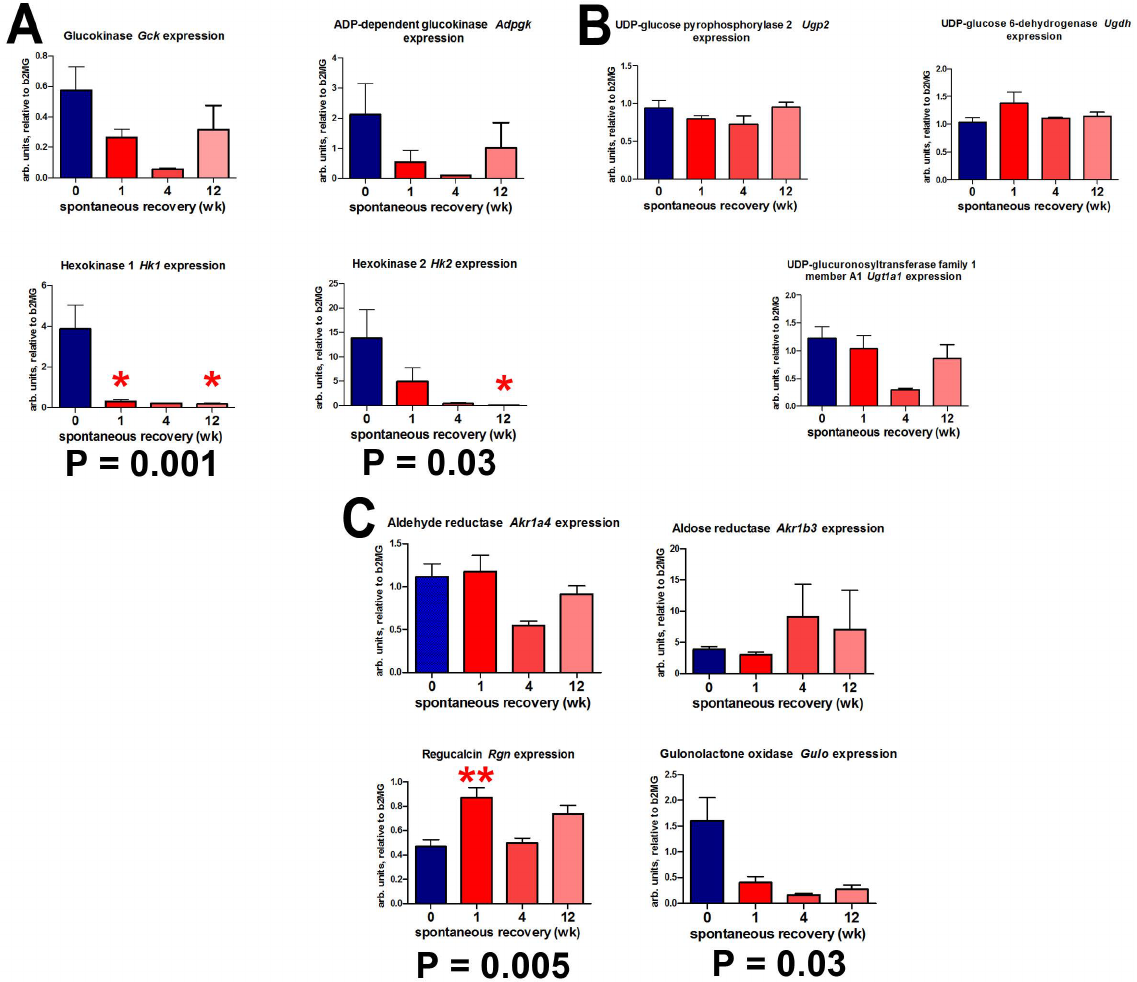
Figure 9. Expression of mouse genes involved in ascorbic acid synthesis from glucose and galactose during spontaneous recovery (for 1–12 week) from HF-CDAA diet-induced liver fibrosis. ( A ). The phosphorylation of hexoses pathway. ( B ). The synthesis of glucuronic acid from glucose 1-phosphate pathway. ( C ). The synthesis of ascorbic acid from glucuronic acid pathway. * = p < 0.05, ** = p < 0.01 compared to start of recovery phase (0 week). p -values represent nonparametric ANOVA (Kruskal– Wallis)